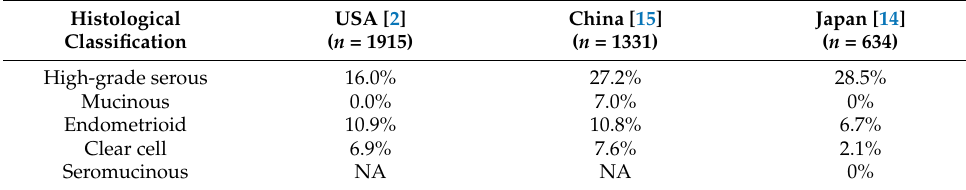
Figure 1. Prevalence of germline BRCA 1/2 pathogenic variants by FIGO stage. The prevalence of g BRCA m of ovarian cancer patients in the Japan CHARLOTTE study was shown. The BRCA pathogenic variant rate was 4.9% and 24.1% in stages I–II and stages III–IV, respectively. VUS: variant of uncertain significance. Table 1. Prevalence of g BRCA m by histological type. NA: not